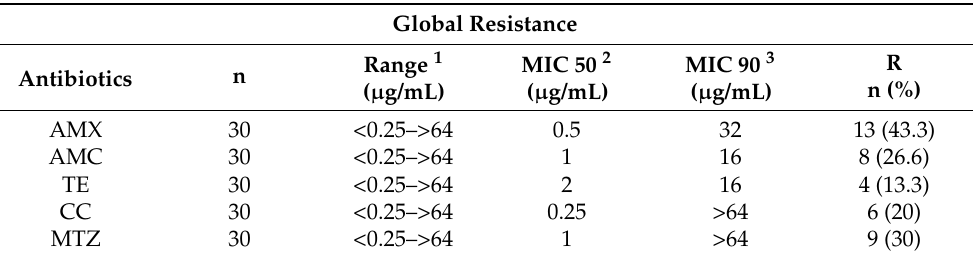
Table 2. Global resistance and minimum inhibitory concentration (MIC) ranges, MIC50, and MIC90 against Prevotella nigrescens, P. intermedia , and P. melaninogenica.